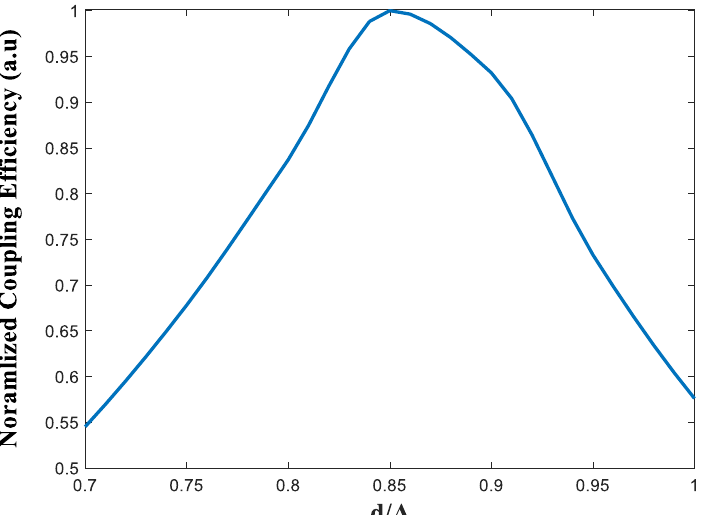
Figure 2. Normalized coupling efficiency as a function of the geometrical parameters of the multicore photonic crystal fiber (PCF) (d/Λ) for the operating wavelengths.